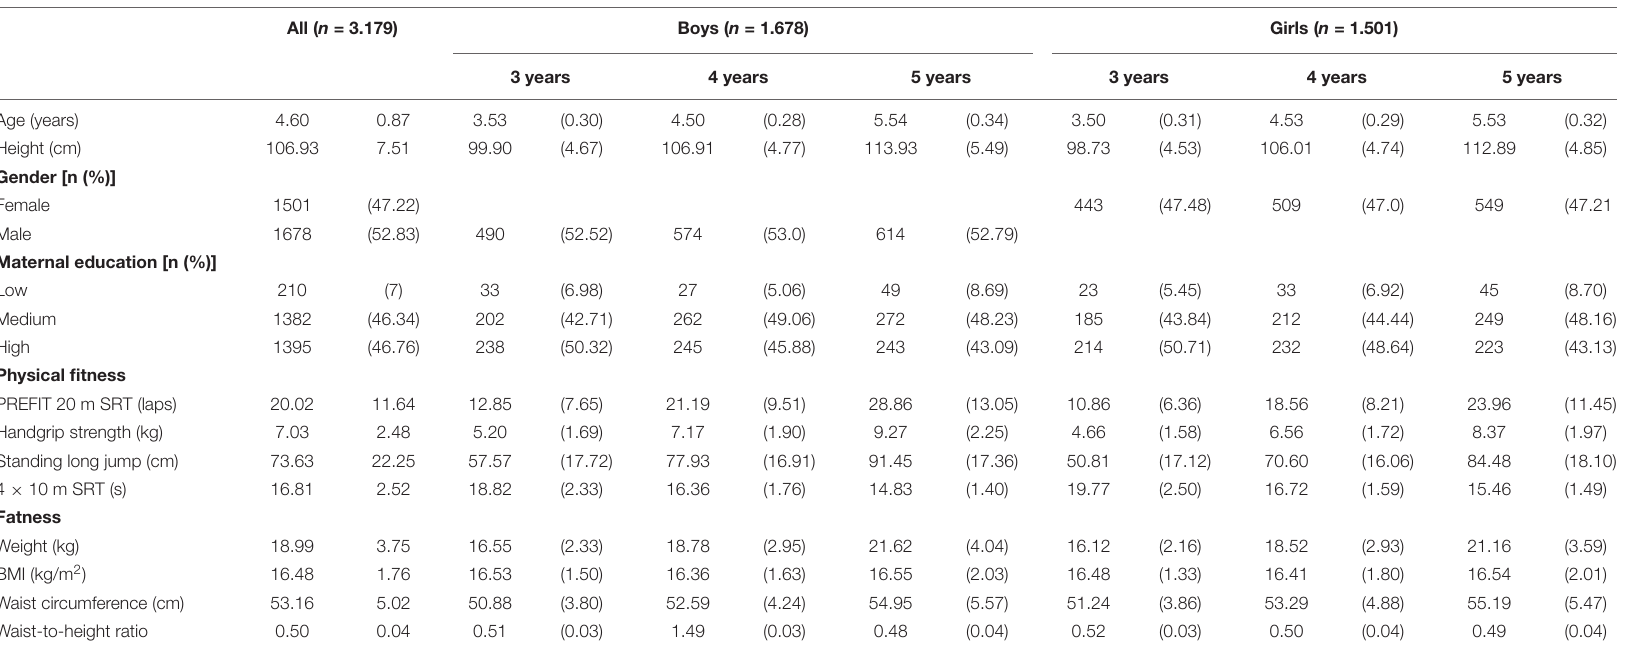
TABLE 1 | Descriptive characteristics of the study population ( n =